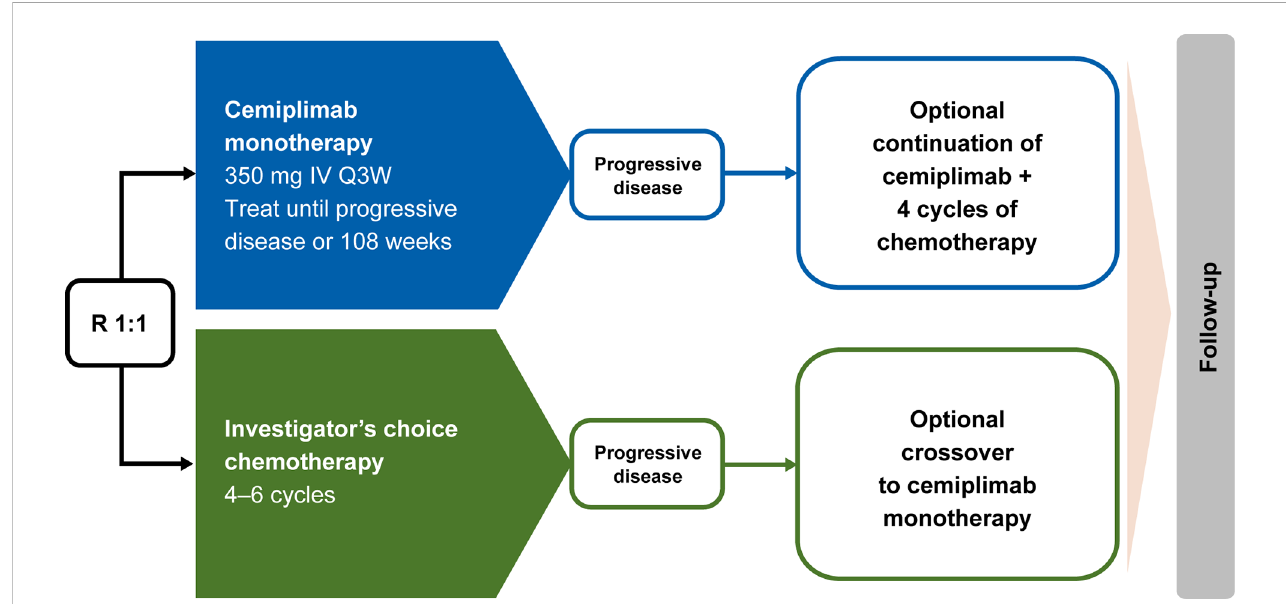
FIGURE 1 EMPOWER-Lung 1 treatment crossover trial design. Conditions for crossover or continued treatment in both trial arms included independent review committee – assessed RECIST 1.1 – de fi ned disease progression. IV, intravenous; Q3W, every 3 weeks; R, randomized; RECIST 1.1, Response Evaluation Criteria in Solid Tumors, version